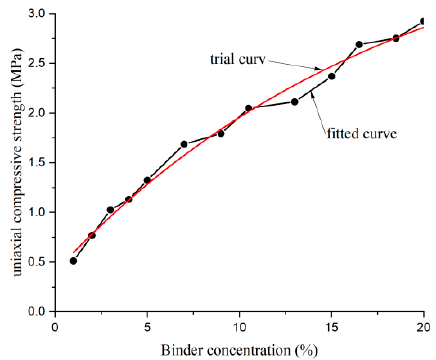
Figure 11. Effects of the binder concentration on the strength.